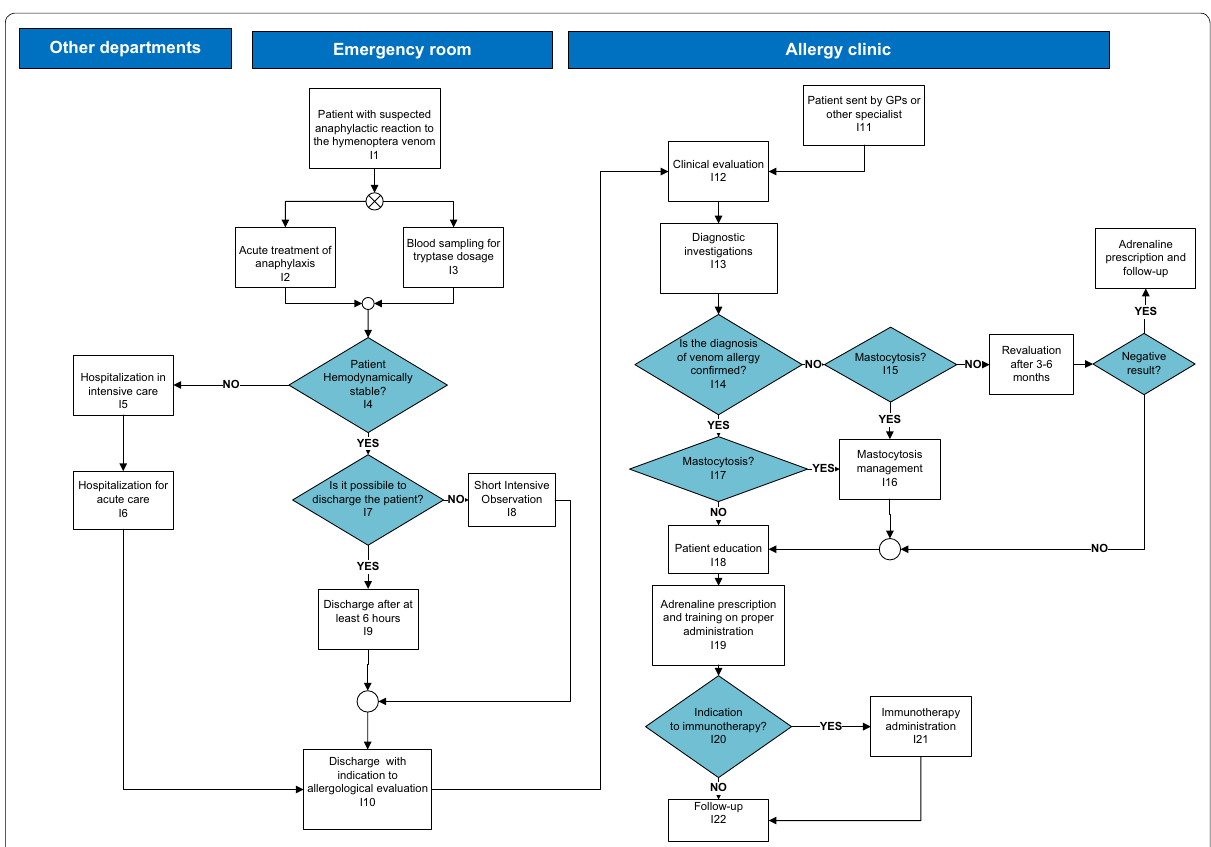
Fig. 2 Process flow diagram for the management of HVA patients